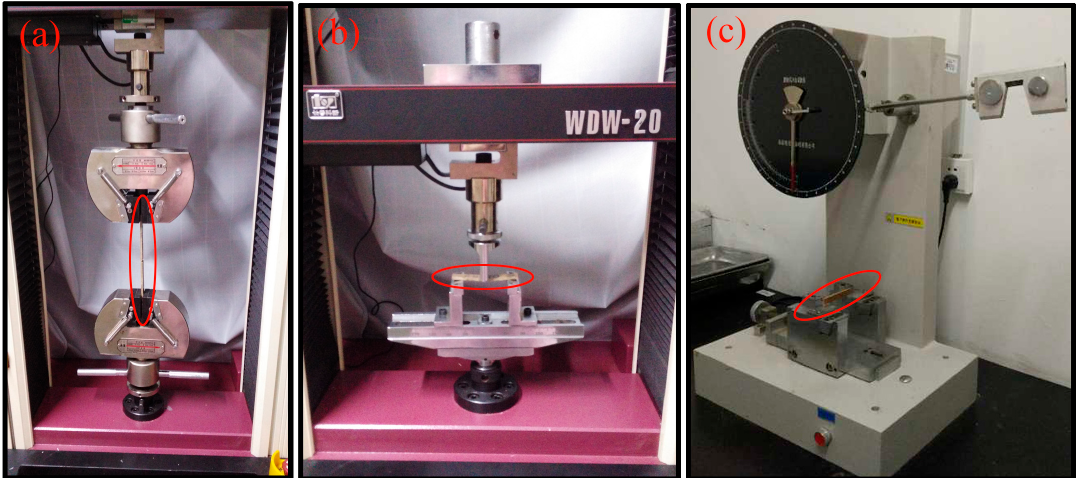
Figure 3. The samples’ ( a ) tensile property being tested; ( b ) the flexural property being tested; and ( c ) the impact property being tested.